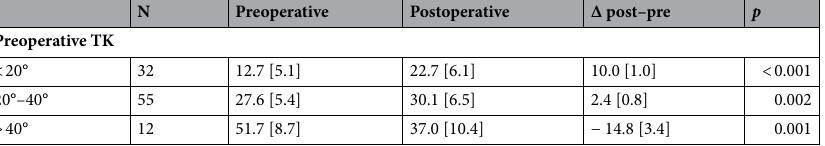
Table 4. Thoracic kyphosis variation in group 1 (all-screws group); patients subgroups according to preoperative thoracic kyphosis; mean [standard deviation]; analysis performed using IBM SPSS Statistics 21. N, number of patients; TK, thoracic kyphosis.